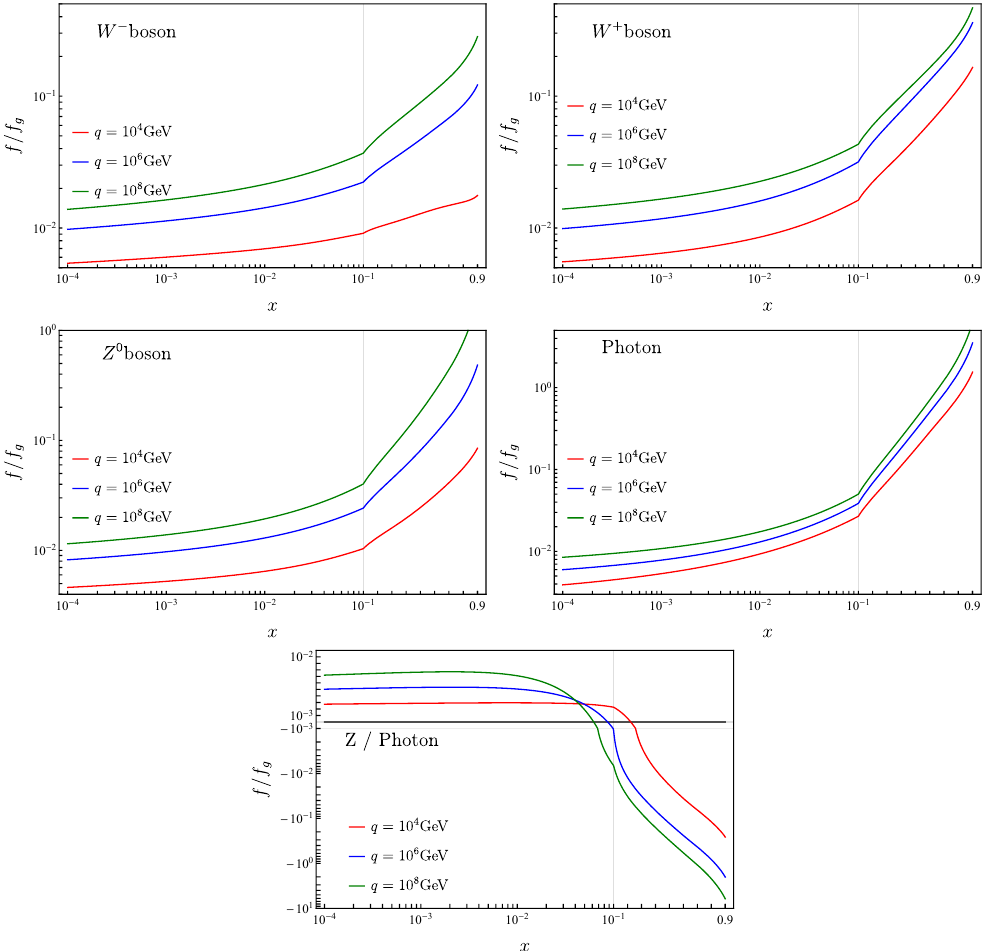
Figure 3 . Electroweak bosons PDF normalized by the gluon PDF. The thin gray lines show where the scales on the x- and/or y-axes switch between linear and